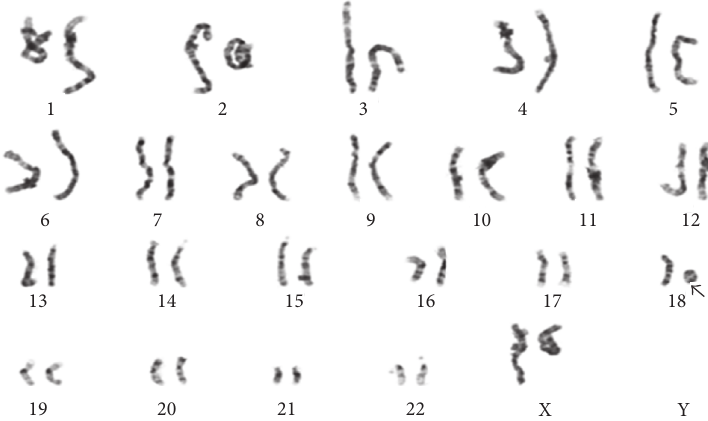
Figure 2: The patient’s karyogram demonstrates a ring chromosome 18.